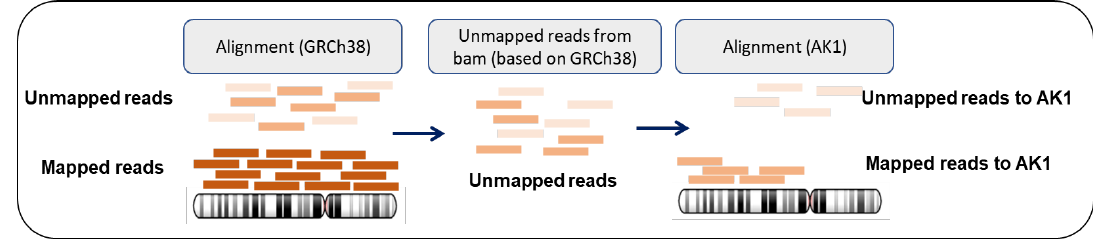
Figure 2. The process of realigning unmapped reads of GRCh38 to AK1.